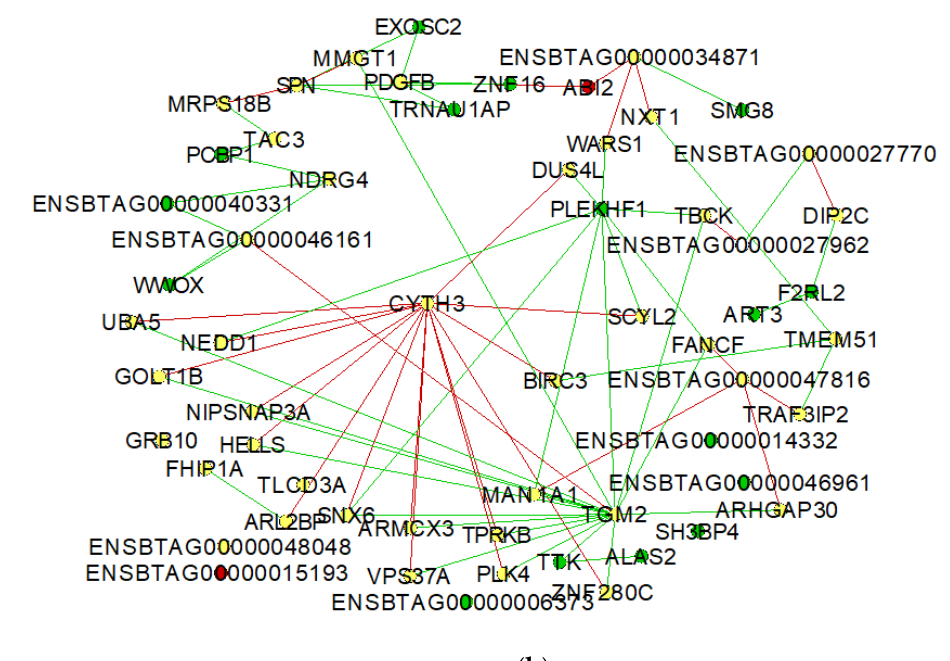
Figure 3. Network comparison based on rewired nodes (genes) of AI-P and NP networks. Central reference network constructed using DyNet in Cytoscape. ( a ) The network comprises 1095 nodes and 1164 edges. The hub targets connected to the network are represented in this network. ( b ) The network was filtered for betweenness centrality to display the hub genes from both groups. The unique nodes are red (AI-P) or green (NP). Shared nodes between AI-P and NP are yellow.